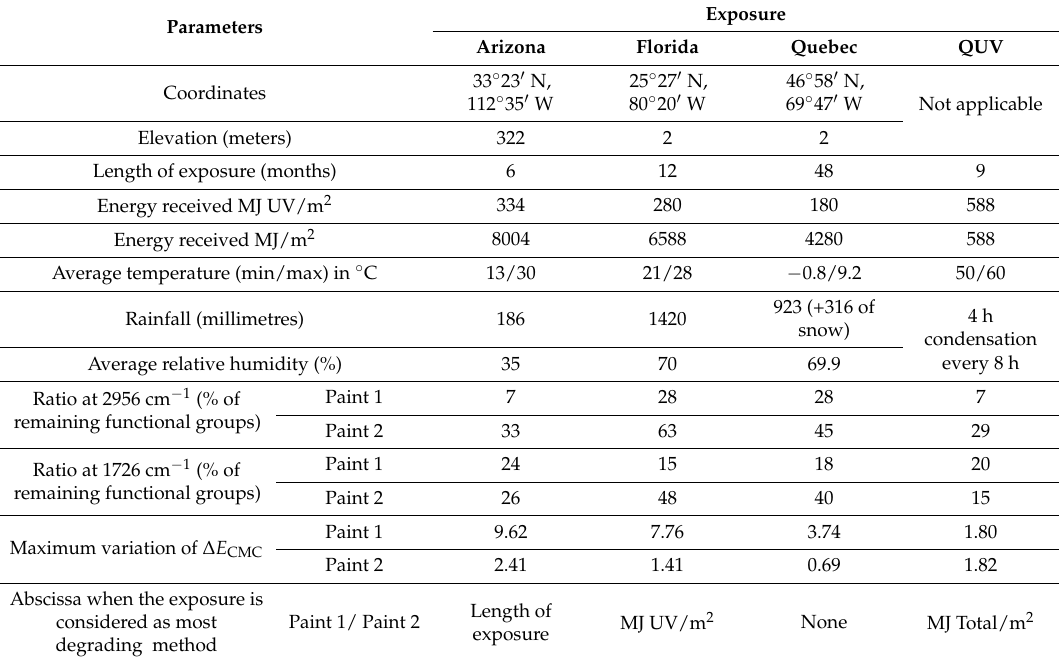
Table 7. Summary of the main results and parameters for each